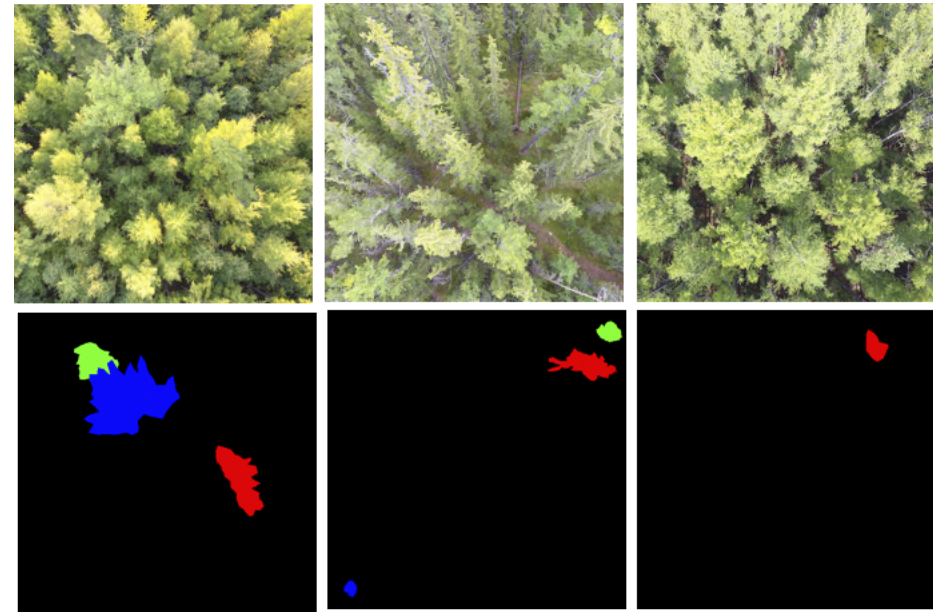
Figure 18. Examples of synthetic images and corresponding masks generated. The images show three drone flight images with a cutout larch tree overlay. The masks below show the location of the placed trees in the form of masks. Each mask is assigned a different color to distinguish the